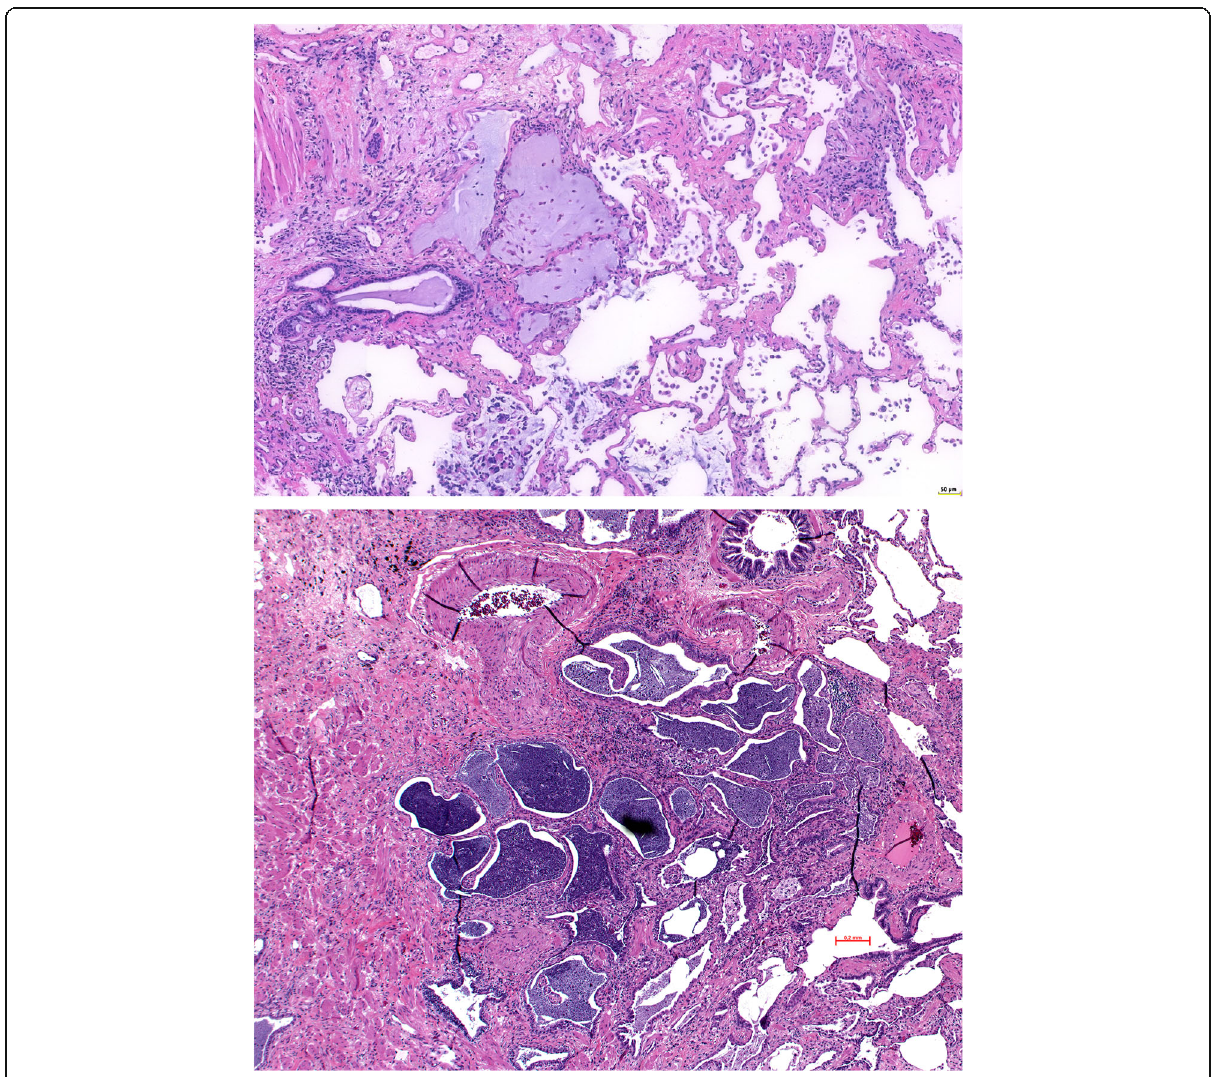
Fig. 5 Mucostasis, in the cystic structures in UIP; in the upper panel there is mucus accumulation with a few scattered macrophages; in the lower panel there is dense spissated mucus, macrophages and scattered neutrophils; this usually is a sign of bacterial colonization. There are also aggregates of lymphocytes around the cysts, which later on can progress into lymph follicles. H&E, bars 50 and 200 μ m